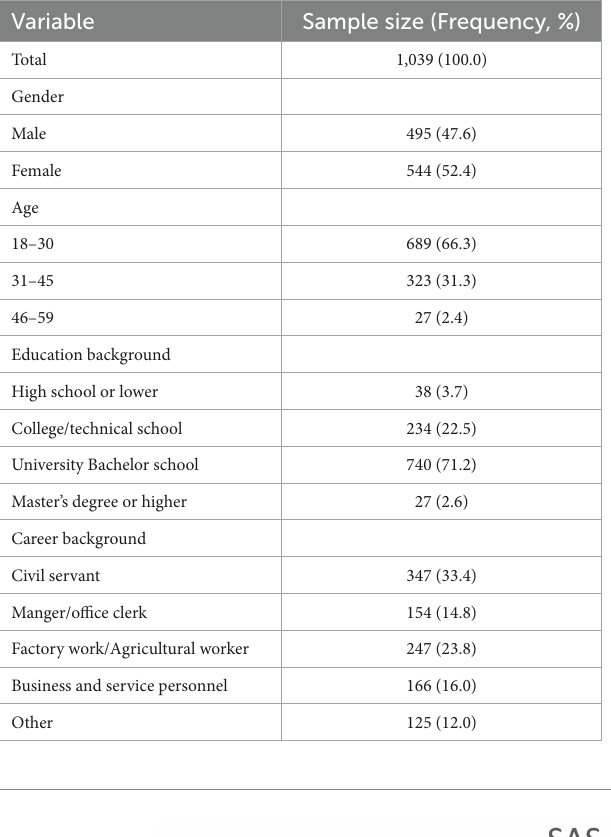
TABLE 1 Demographic information of participants.